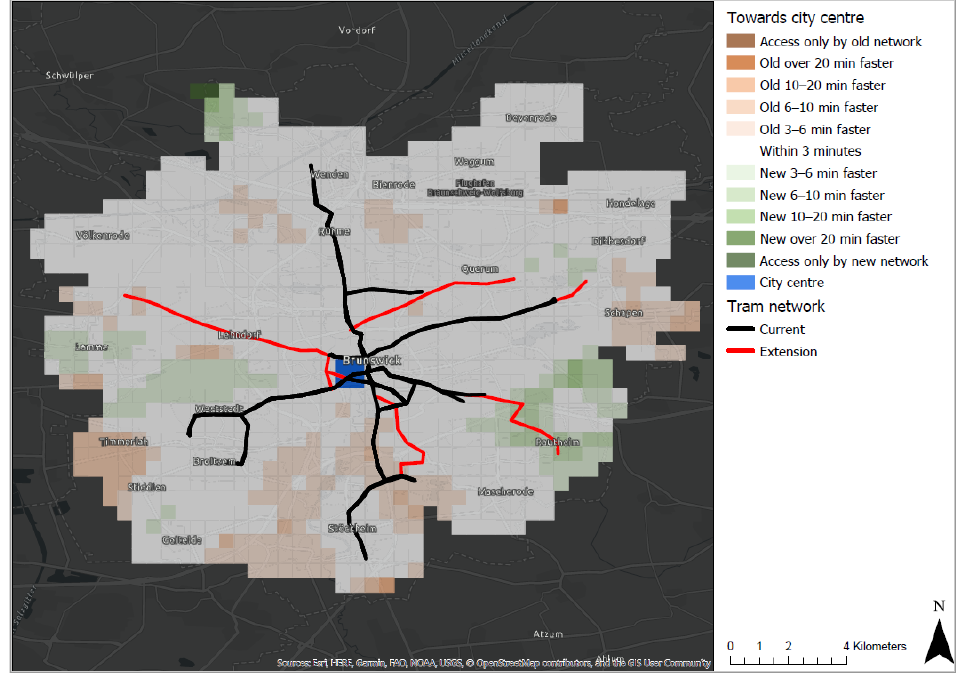
Figure 5. Difference on time taken to reach the city centre in Braunschweig, Germany.